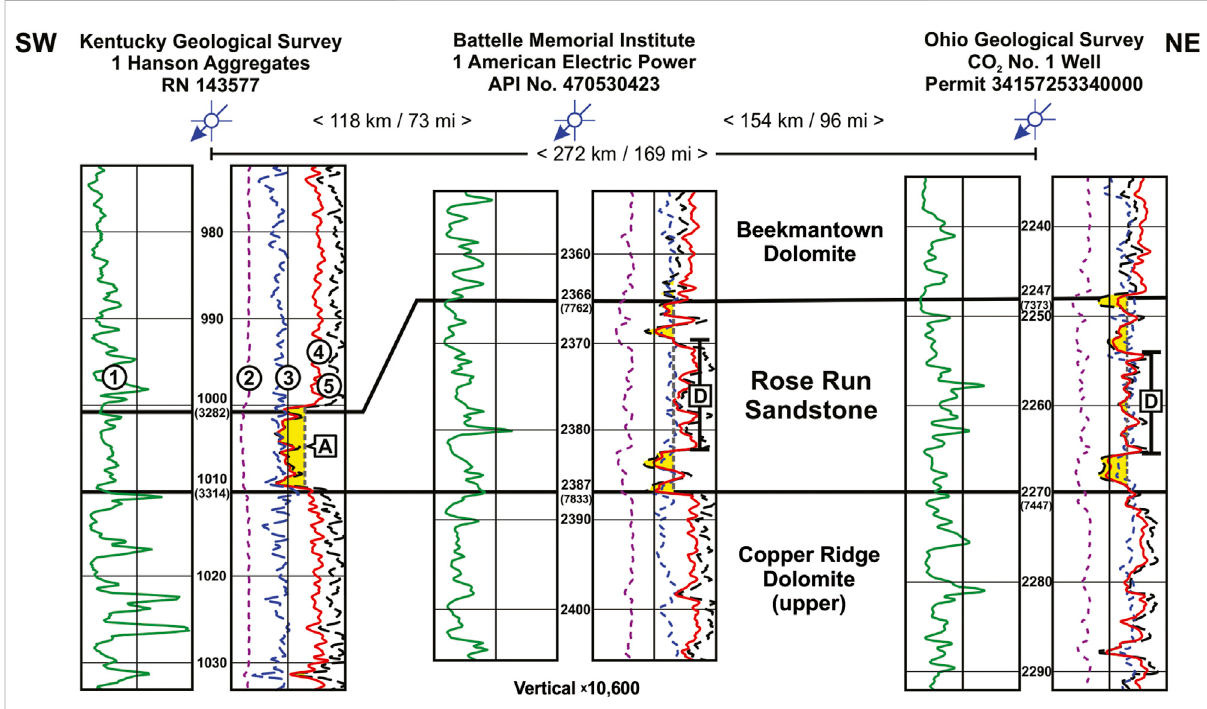
FIGURE 6 Comparison of the Rose Run sections in the KGS 1 Hanson Aggregates well, Battelle 1 AEP well, and Ohio CO 2 No. 1 well (Figure 1). Depths are meters below the rig kelly bushing. The Rose Run section thickens to the northeast where thick, porous sand beds (yellow fi ll) are separated by a middlesectionofthin,low-porositysandanddolomitebeds.Logcurvesshownarethegamma-ray(curve1,lefttrack),PEcurve(curve2,righttrack), neutron porosity (curve 3right track), formation density (curve 4, right track), and density porosity (curve 5, right track). Dashed line A is a 7% porosity (yellow fi ll) cutoff, and D is the dolomitic section in the downdip Rose Run